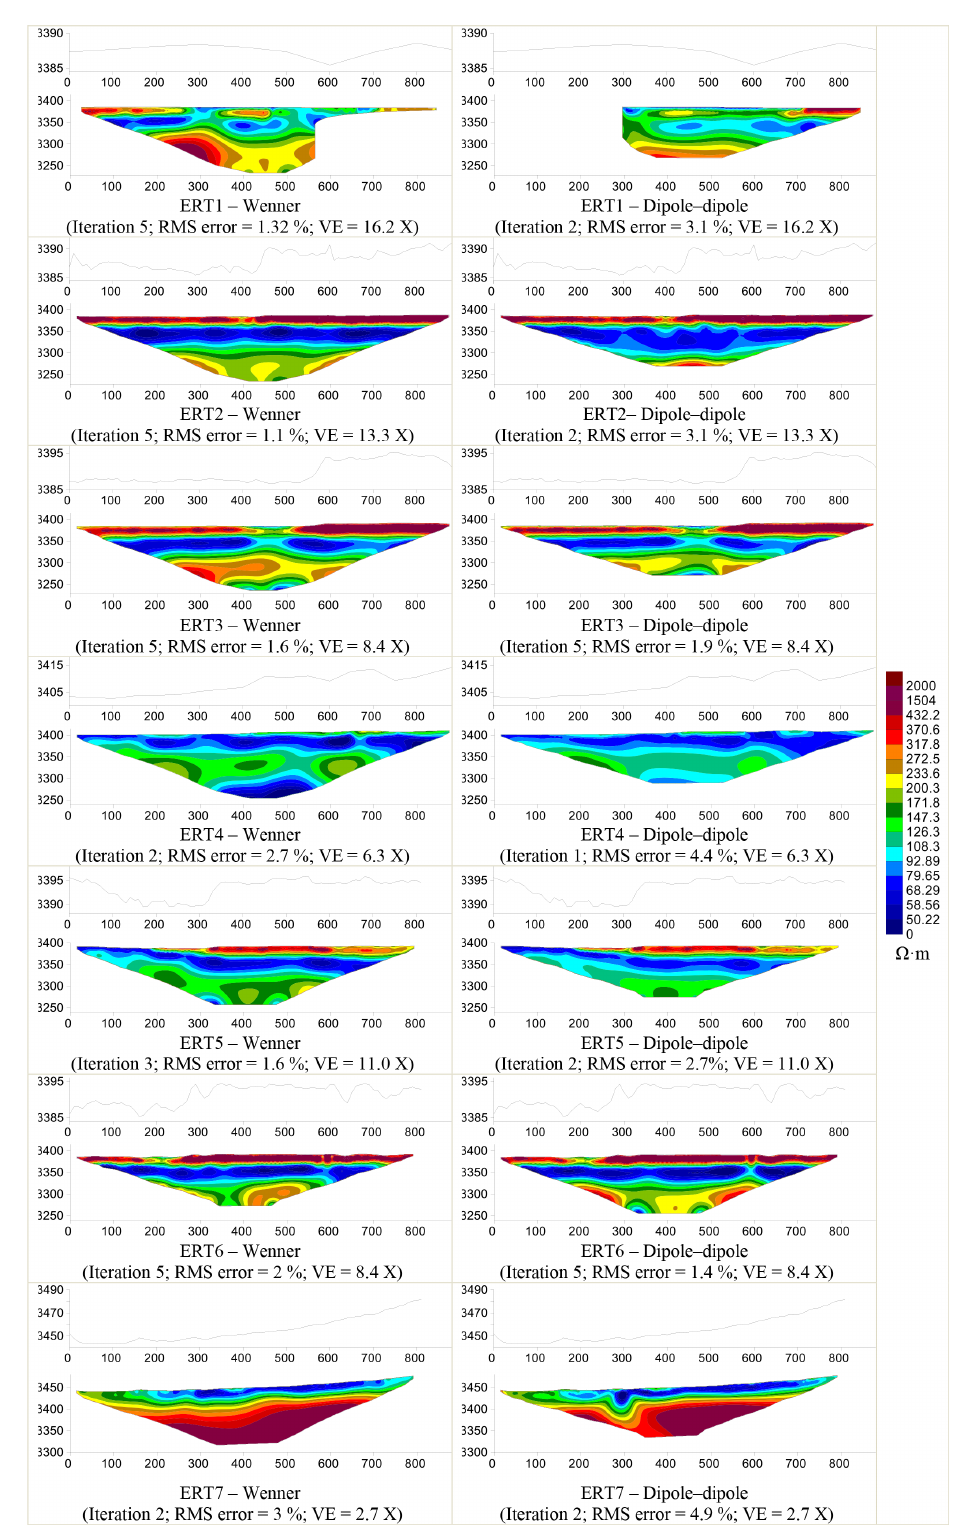
Figure A2. ERT measurements and corresponding ground surface elevation and vertical exaggeration (VE).